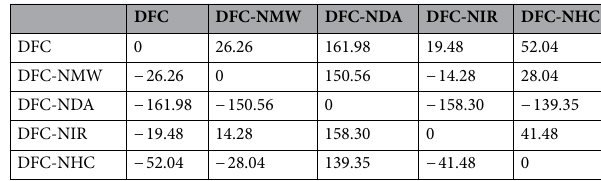
Table 2. McNemars test results for Flevoland dataset achieved by using 100 training samples per class.